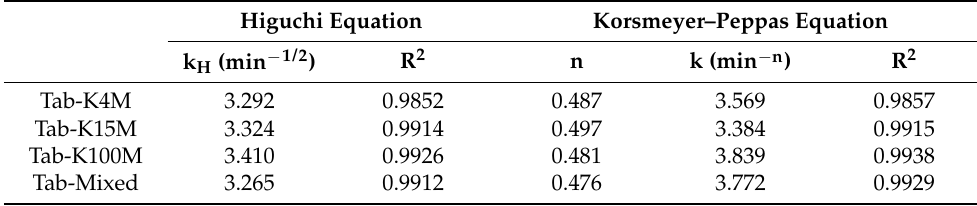
Table 3. Higuchi and Korsmeyer–Peppas model fitting of release data.